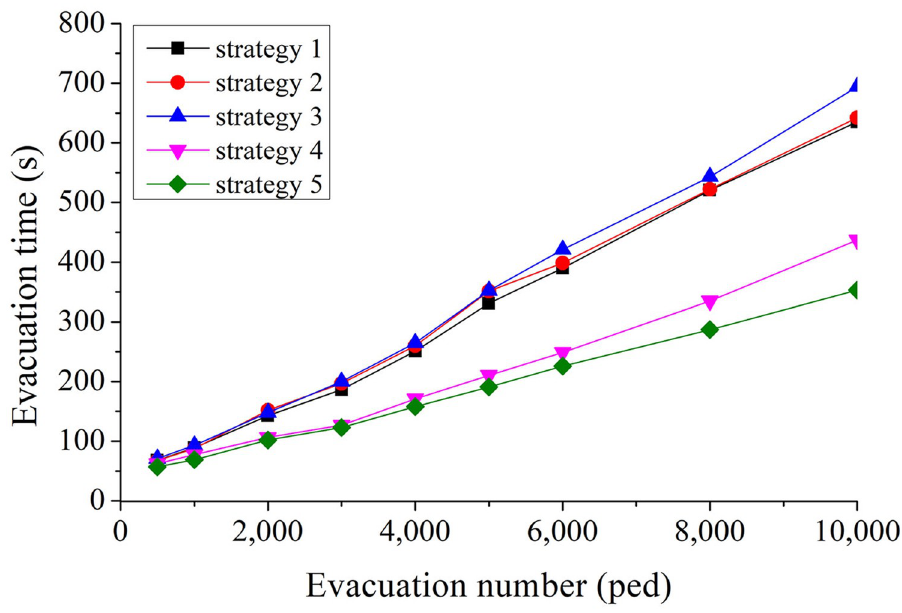
Fig 5. Comparison of evacuation time under five evacuation